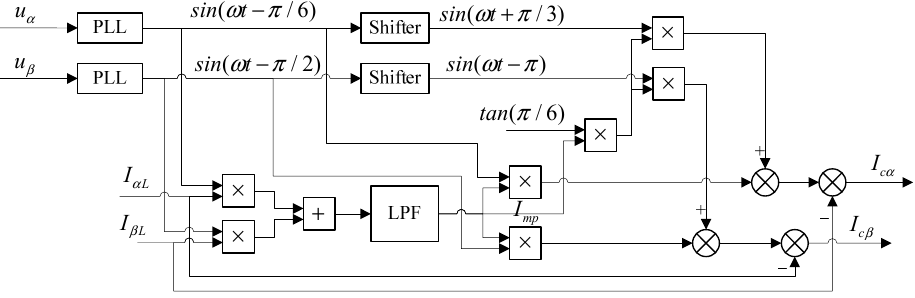
Figure 3. The implementation of current references for RPC.